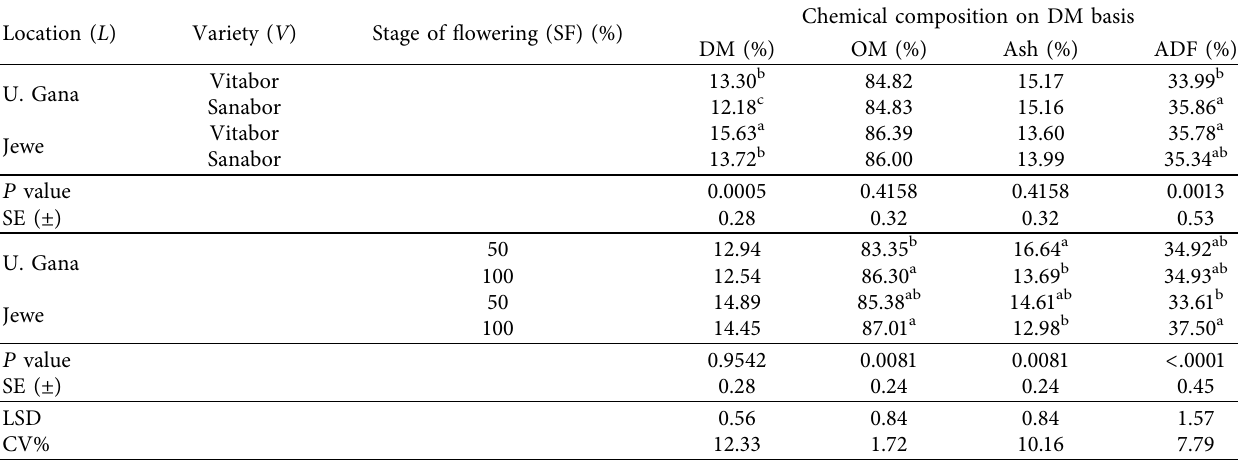
Table 3: Effects of location, variety, and stage of flowering on dry matter, organic matter, total ash, and acid detergent fiber. Location ( L